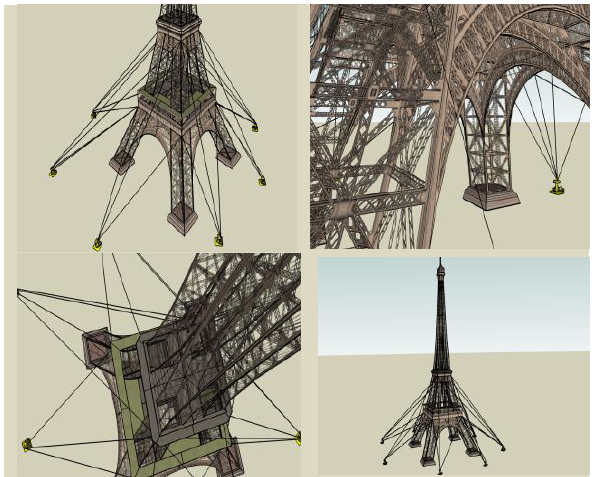
Figure 7. Illustration of the configuration